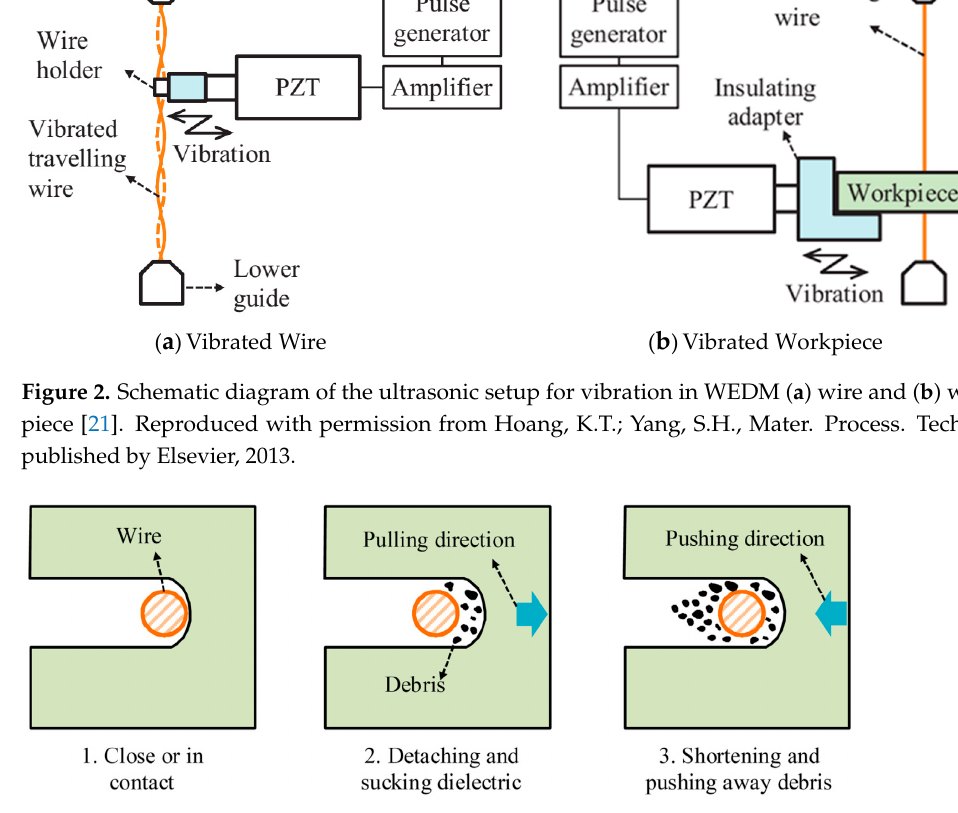
Figure 3. Principle of debris removal during ultrasonic vibration-assisted WEDM [21]. Reproduced with permission from Hoang, K.T.; Yang, S.H., Mater. Process. Technol.; published by Elsevier,